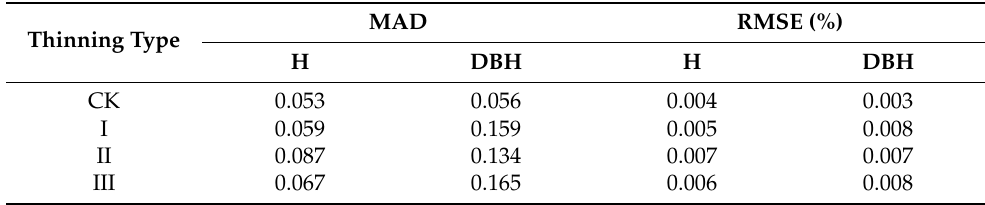
Table 3. Results of model reliability.